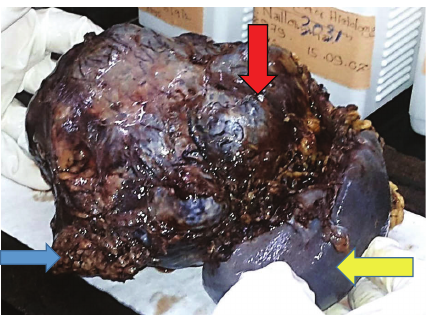
Figure 3: Macroscopic appearance of distal pancreatectomy with splenectomy specimen containing well-demarcated lobulated mass (red arrow), part of body of pancreas (blue arrow), and spleen (yellow arrow).